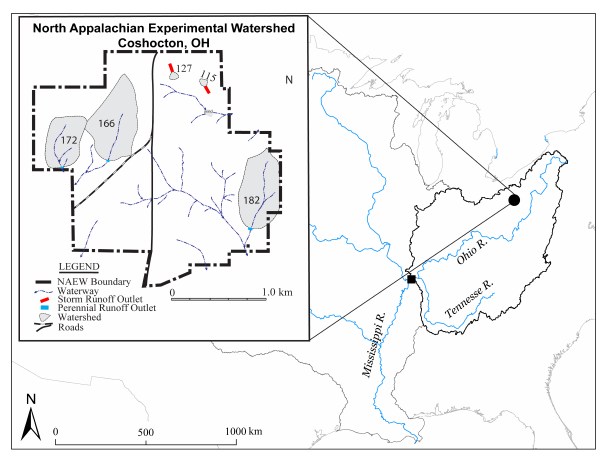
Fig. 1. Map of the USDA North Appalachian Experimental Water- shed (NAEW) watersheds, Ohio, shown with respect to the Ohio- Tennessee River subbasin of the Mississippi-Atchafalaya River Basin. NAEW watersheds include: WS 115 Corn No-Till, WS 127 Corn Till, WS 166 Mixed-Use, WS 172 Forest, and WS 182 Unim- proved